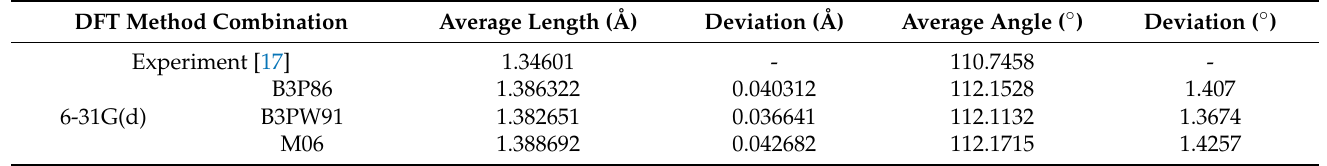
Table 1. Average bond length and average angle of UO 2 (L)(MeOH) in the optimized structure. DFT Method